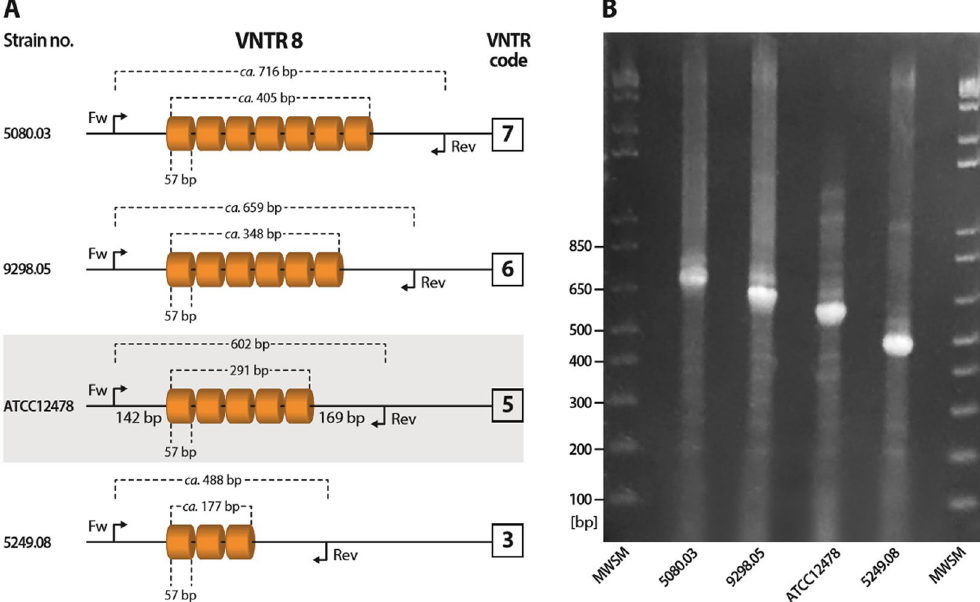
Figure 1. Polymorphism of the VNTR 8 locus. ( A ) Schematic representation of allelic diversity of the VNTR 8 locus among isolates under the study. ( B ) PCR-amplified VNTR 8 locus in four M. kansasii isolates showing bands of different length corresponding to different number of repeats within the locus. MWSM, molecular- weight size marker (100 bp DNA ladder, New England BioLabs, Ipswich,